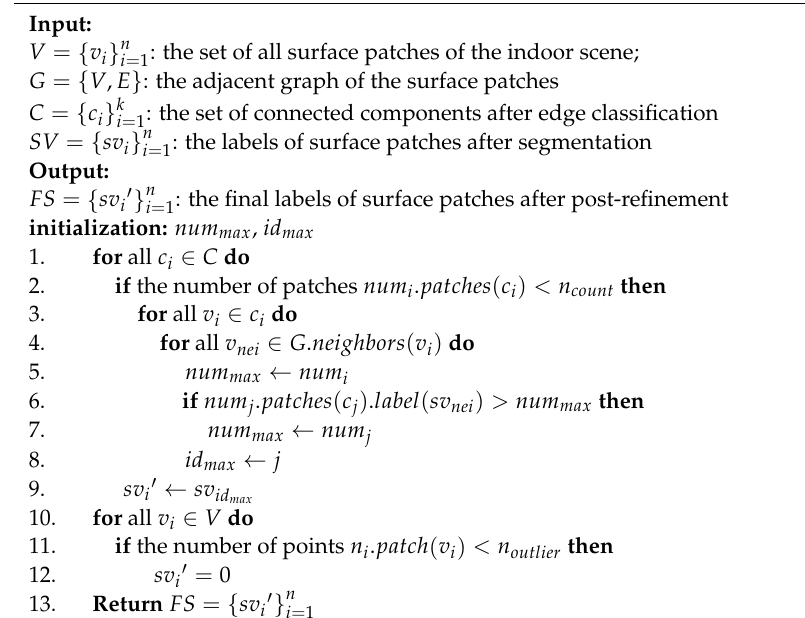
Algorithm 3 . Segmentation